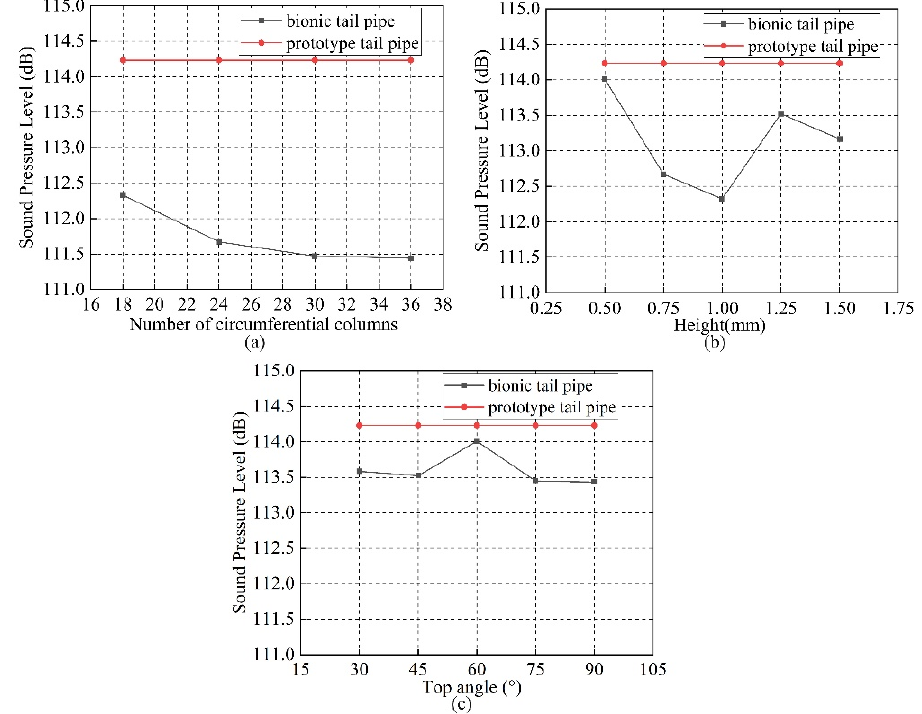
Figure 9. Effect of dimension parameters on total sound pressure level of bionic tailpipes: ( a ) circumferential column number n, ( b ) texture height h, ( c ) top angle θ .